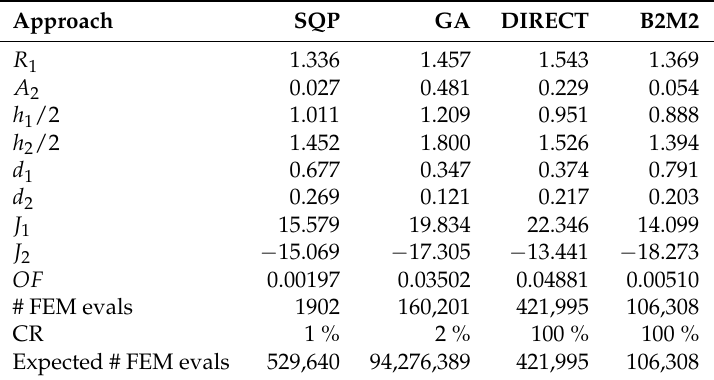
Table 4. TEAM Workshop problem 22 optimization